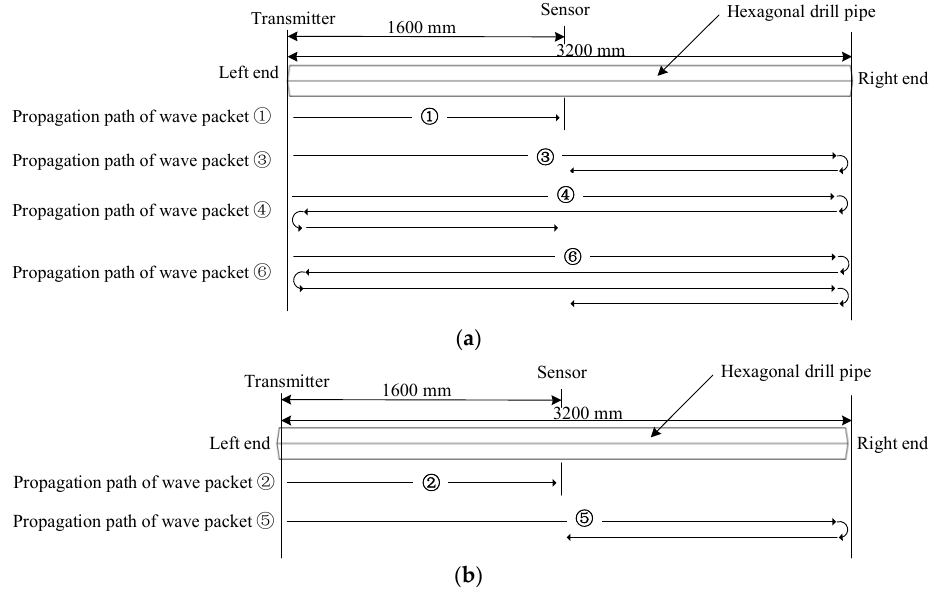
Figure 13. Wave propagation path analysis for each wave packet in the time domain waveform received from a hexagonal drill pipe without ALID regions: ( a ) L(0,2) mode; and ( b ) L(0,1) mode.